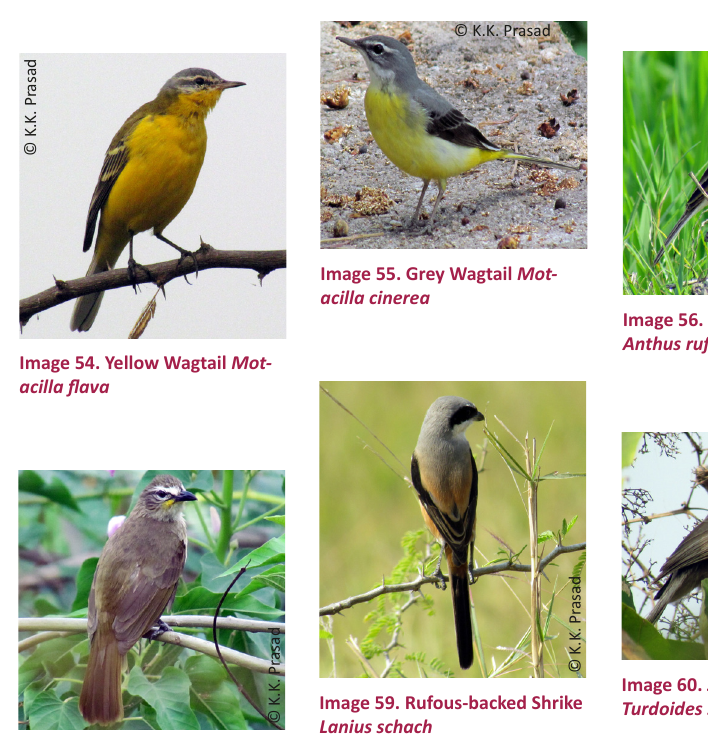
Image 60. Jungle Babbler Turdoides striatus